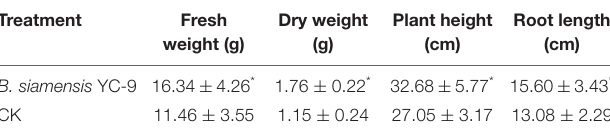
TABLE 2 | Effect of B. siamensis YC-9 on growth of cucumber seedlings. Treatment